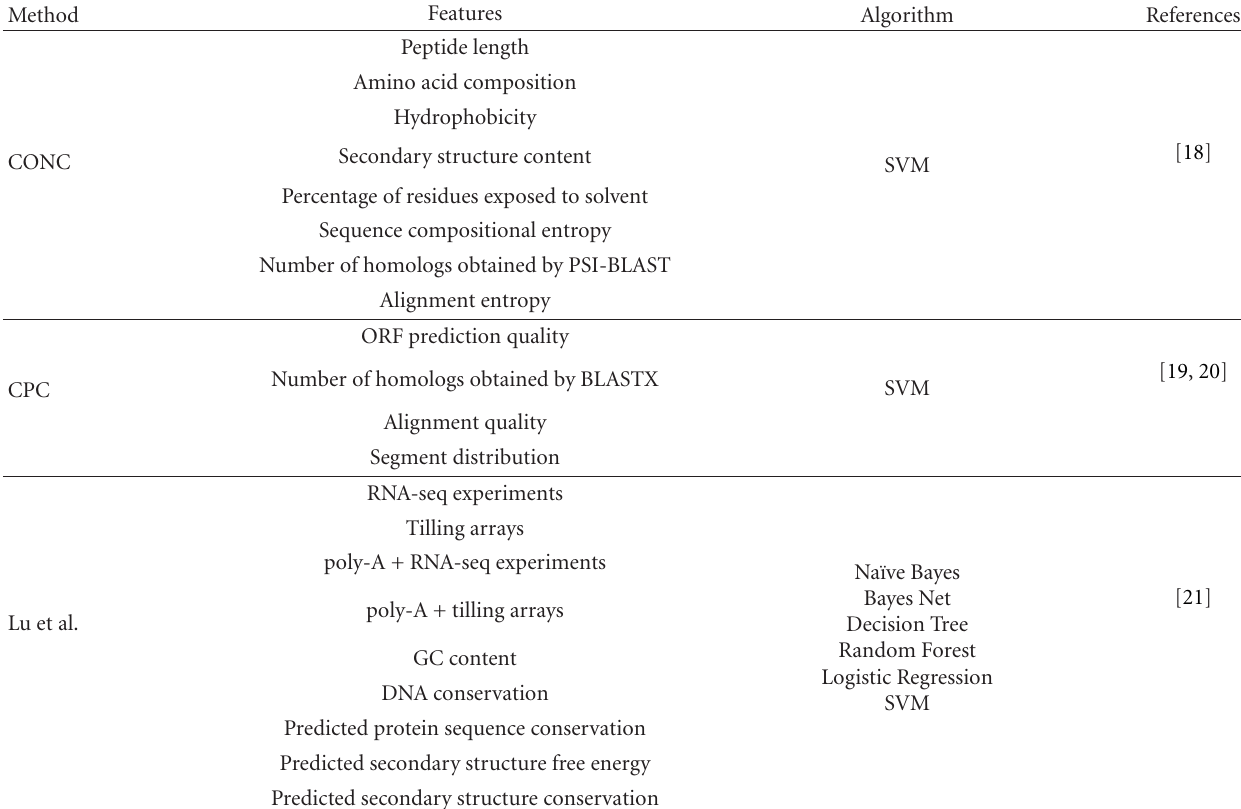
Table 1: Machine-learning methods for identifying